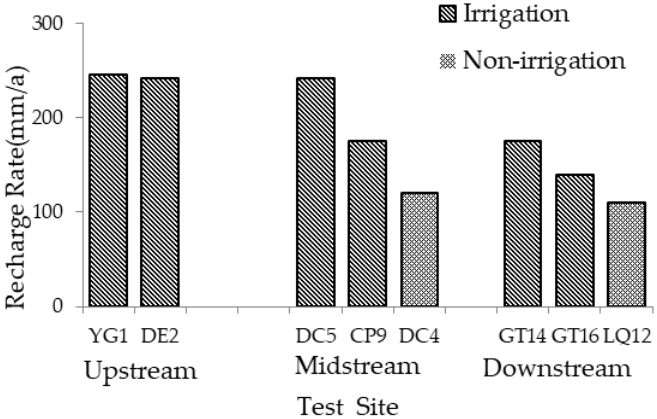
Figure 6. The recharge rate of groundwater in different irrigated district location.